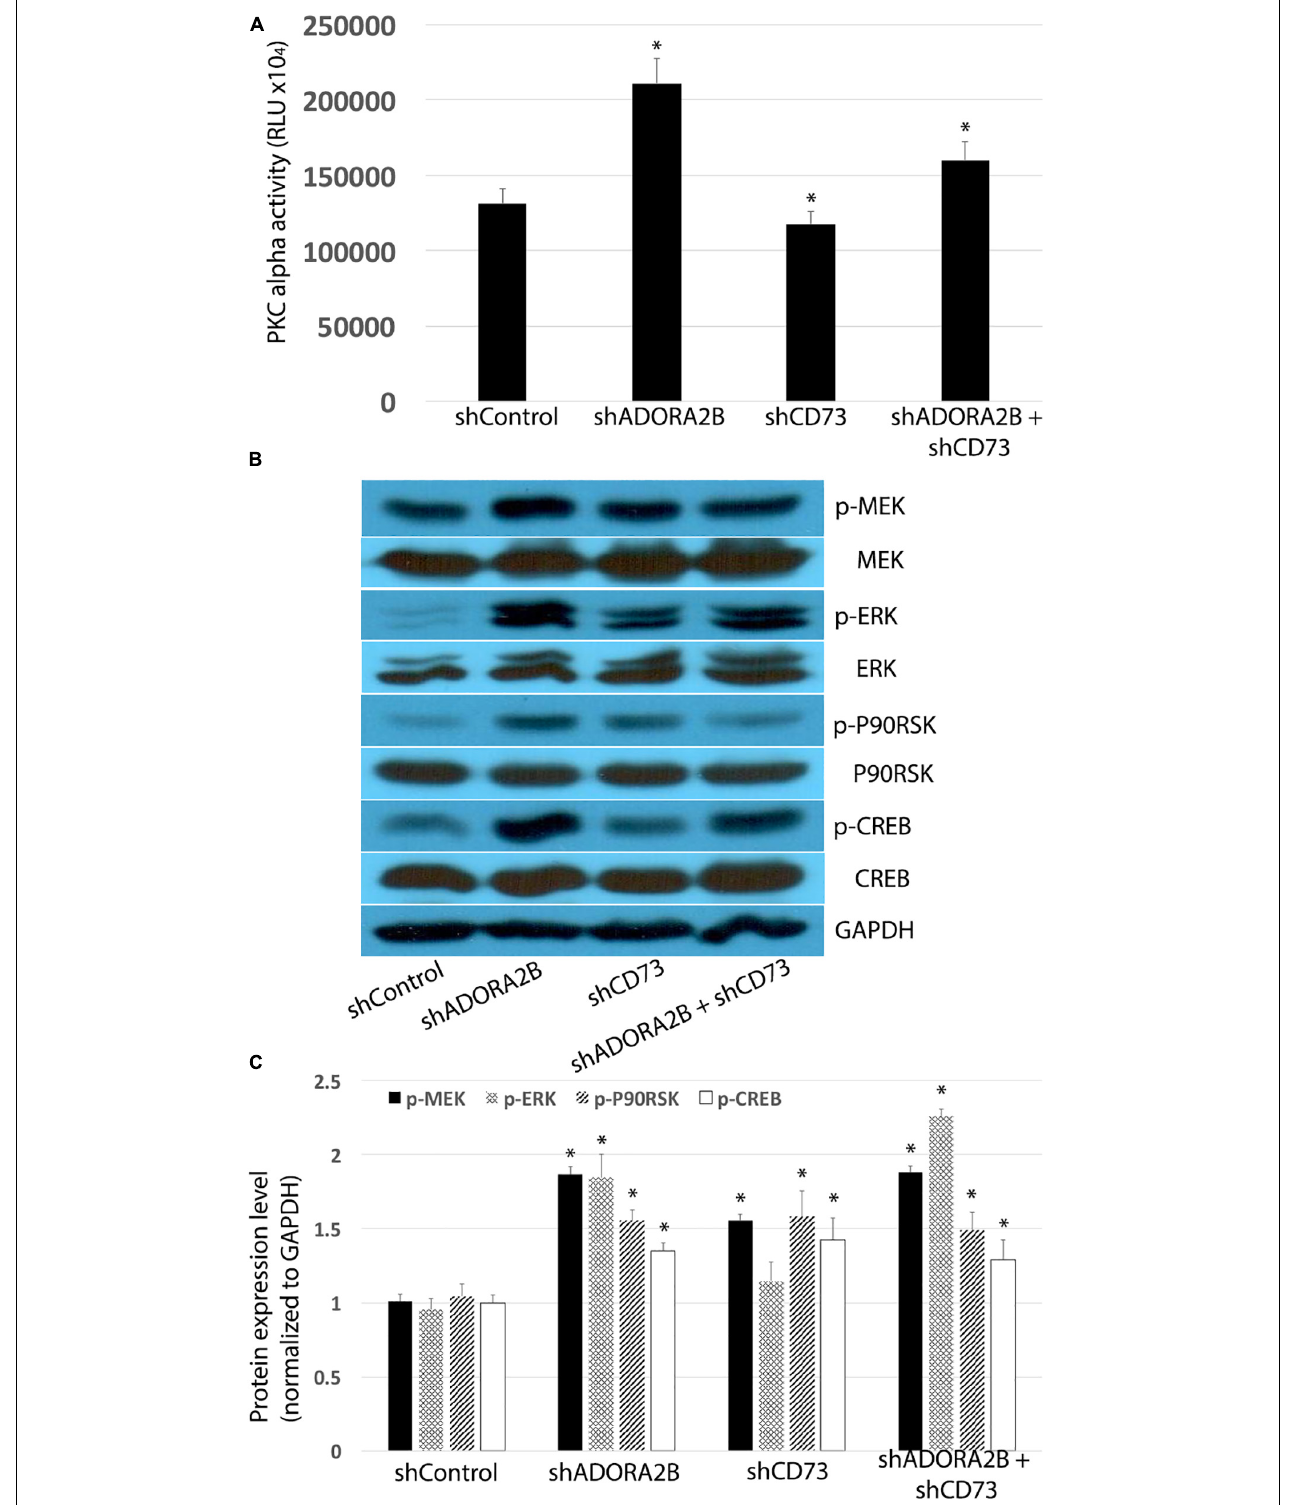
FIGURE 5 | (A) Knocking down ADORA2B alone or both ADORA2B and CD73 activates PKC alpha in LTC. Data are mean ± SE, ∗ indicated p < 0.05. (B) Knocking down ADORA2B and CD73 activates MEK/ERK/p90RSK/CREB signaling pathway. (C) Normalized densitometry analysis of p-MEK, p-ERK, p-p90RSK, and p-CREB. Data are mean ± SE, ∗ indicated p < 0.05.